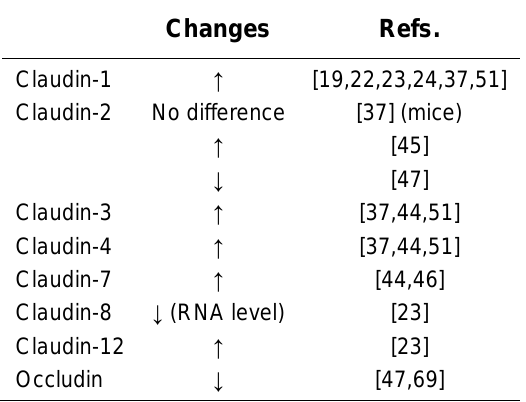
Changes in TJ Protein Expression in Human CRC Samples